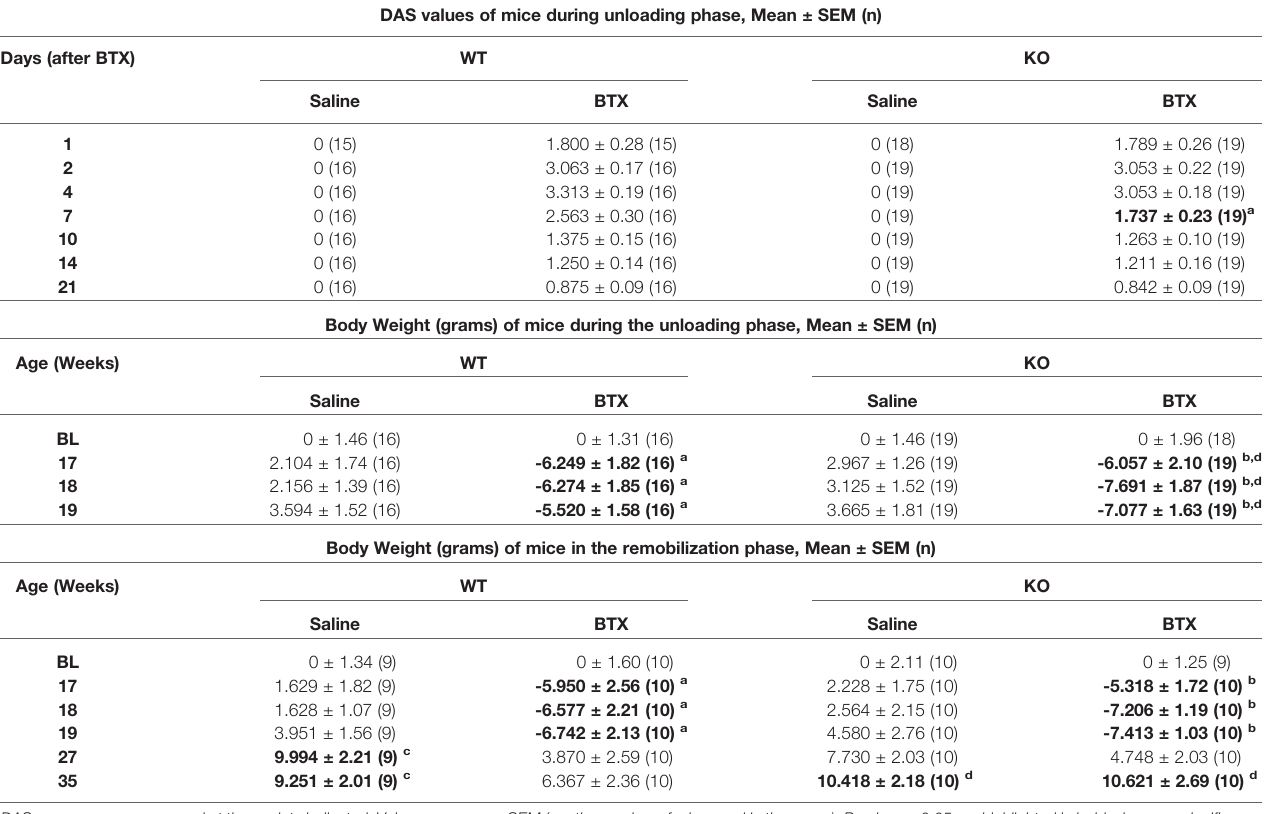
DAS response was measured at time points indicated. Value are means ± SEM (n = the number of mice used in the group). P-values < 0.05 are highlighted in bold where a = signi fi cance fromBTX WT. Bodyweightis calculatedas percentage change from baseline (BL,16weekof age)=(Weight atage mean – Weightat BL mean )/Weightat BL mean ×100.P-values <0.05are highlighted in bold where signi fi cance from saline (a = WT, b = KO); and signi fi cance from BL (c = WT, d =